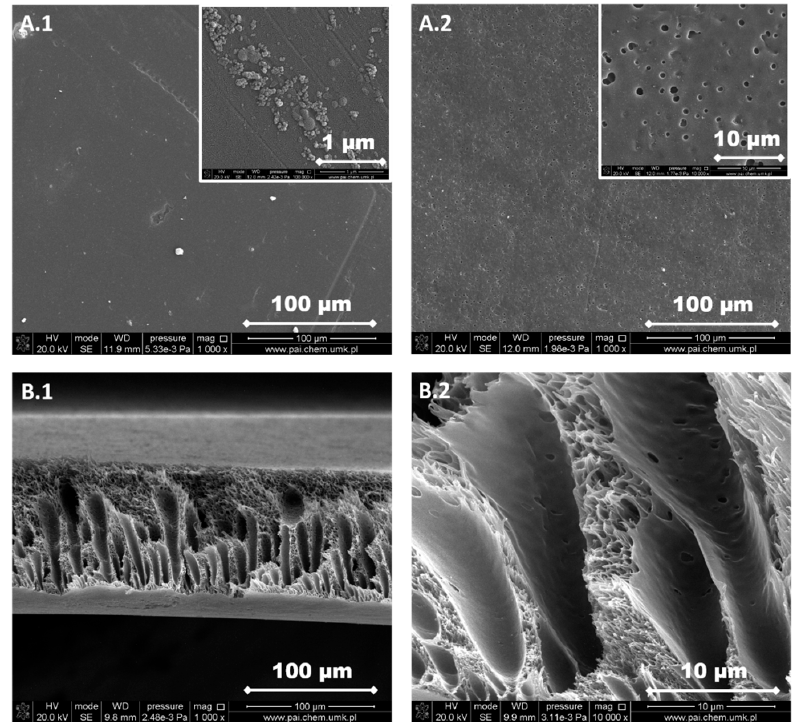
Figure 6. SEM images of M4 membrane ( A.1 ) Selective layer, ( A.2 ) support layer, ( B.1 ) a cross-section of the membrane, and ( B.2 ) a cross-section of the membrane at higher magnification.